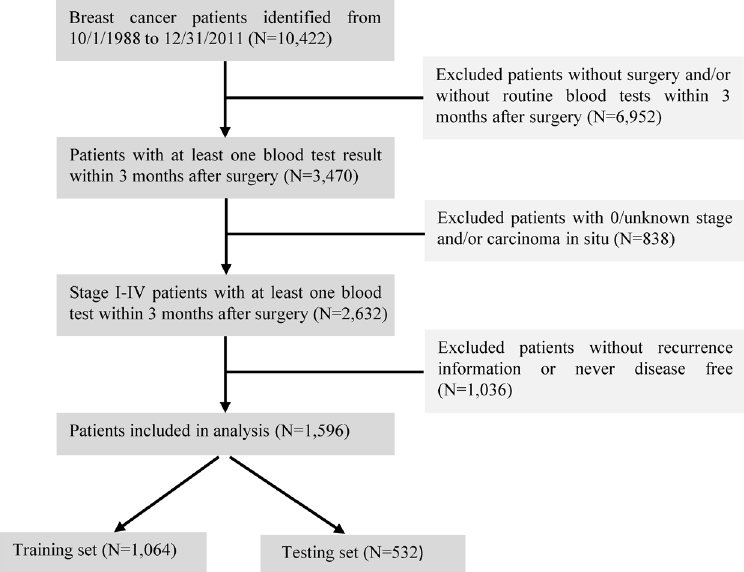
Figure 1. Diagram of Study Population Selection. All of patients were histologically confirmed as having breast cancer and were diagnosed and/or treated in the Kimmel Cancer Center at the Thomas Jefferson University Hospital. A cohort of 1,596 breast cancer patients was included in this study based on the selection